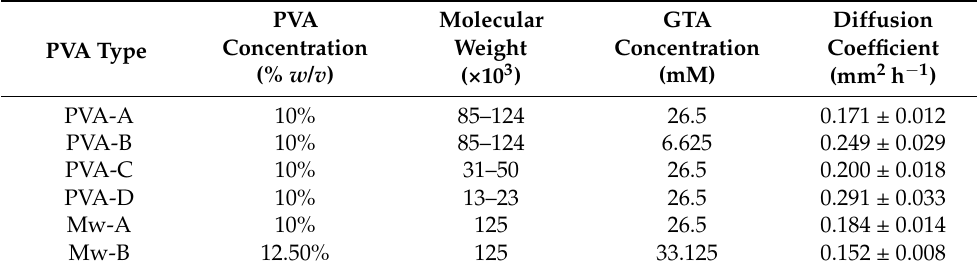
Table 2. Diffusion coefficients of the investigated PVA Fricke gels. Adapted from